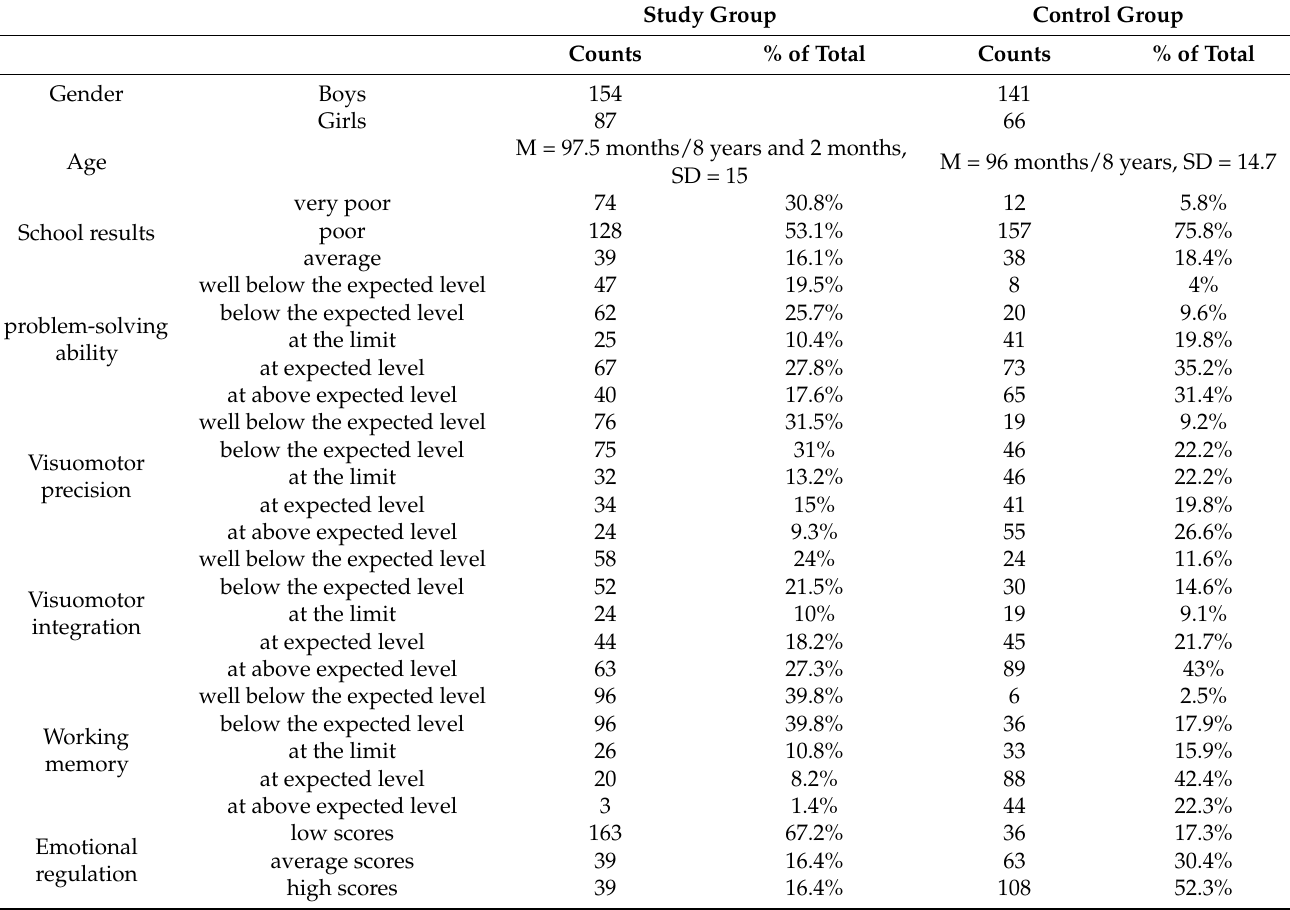
Table 1. Characteristics of the participants.